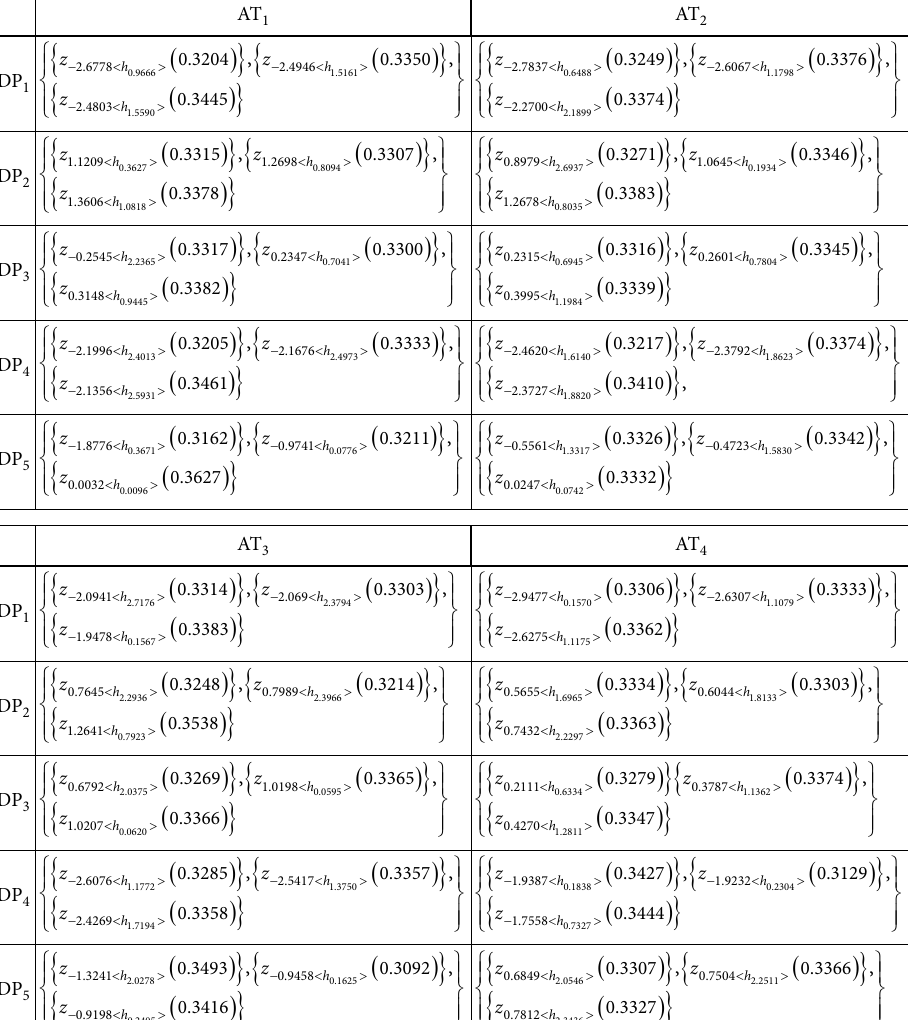
Table 15. The normalized overall decision matrix AT 1 AT